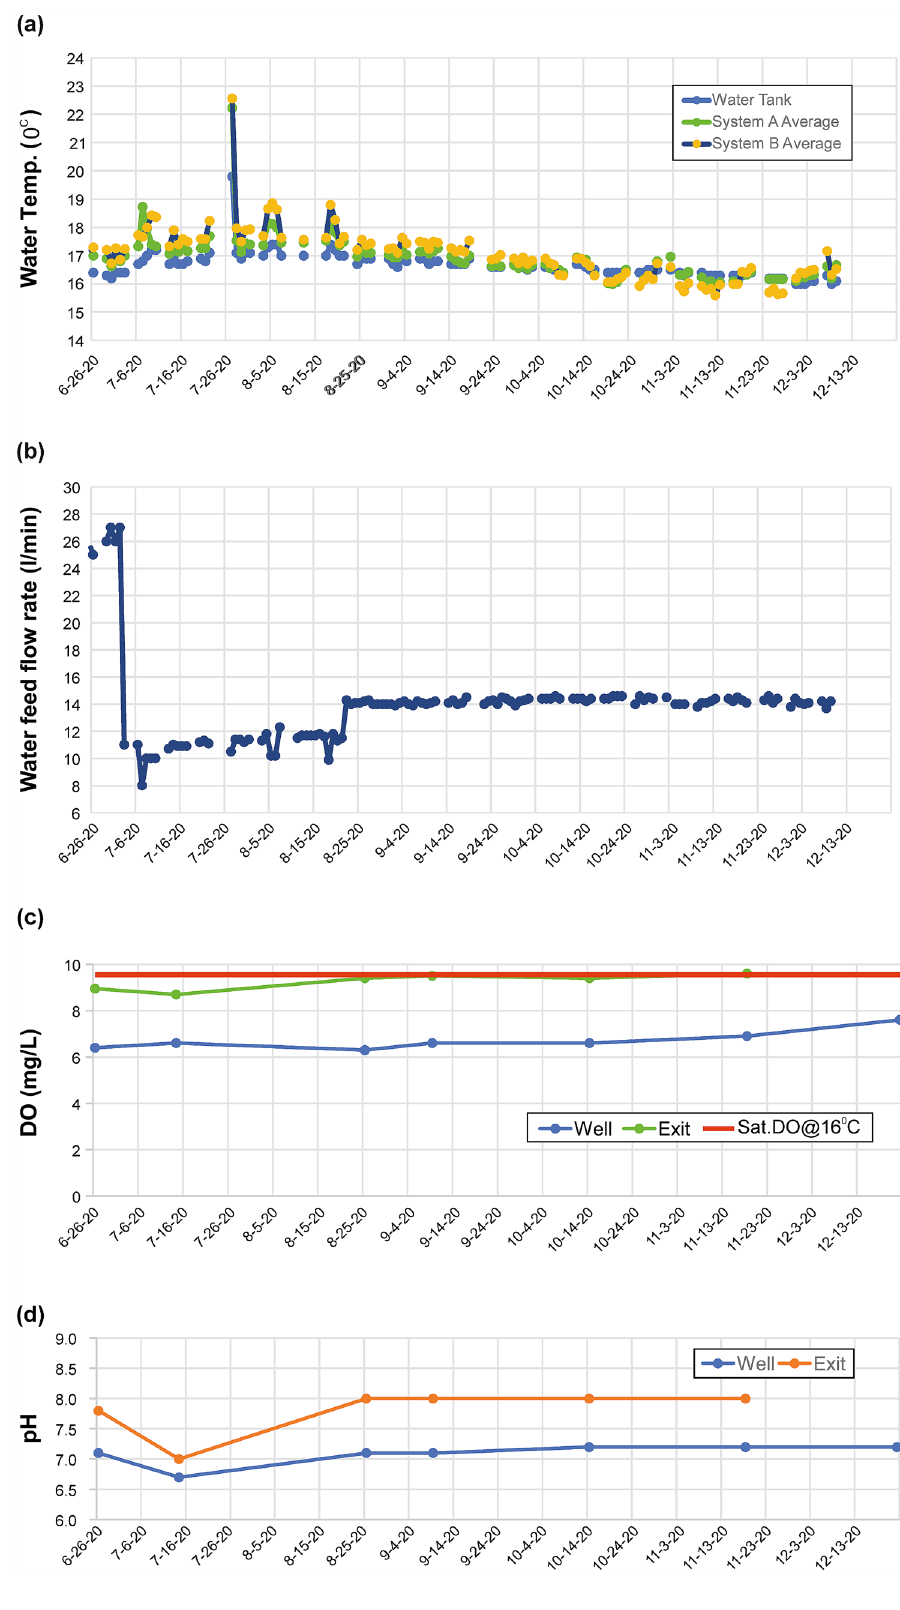
Fig. 7 Firefly breeding data, a water temperature, b water supply flow, c dissolved oxy- gen concentration, d